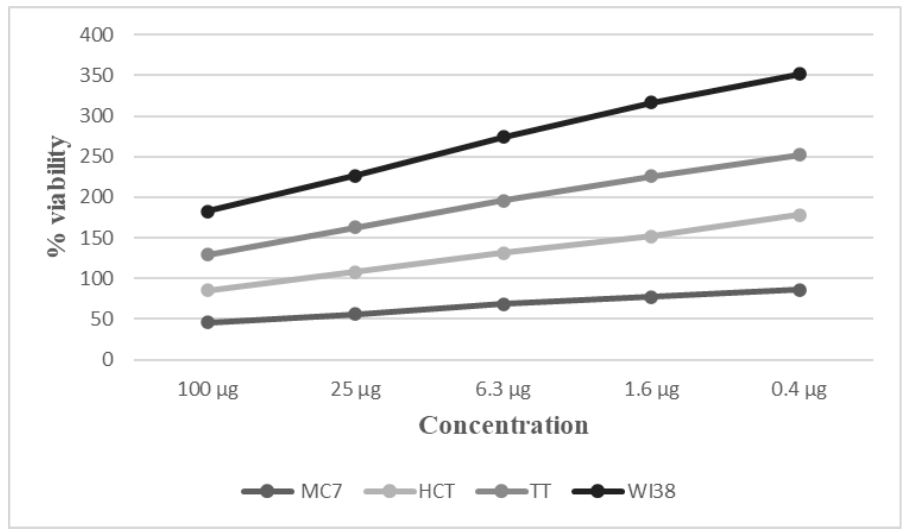
Figure 2. IC50 values of Clitoria ternatea ethanolic extract against HCT116, MCF-7, and TT cell lines and staurosporine .